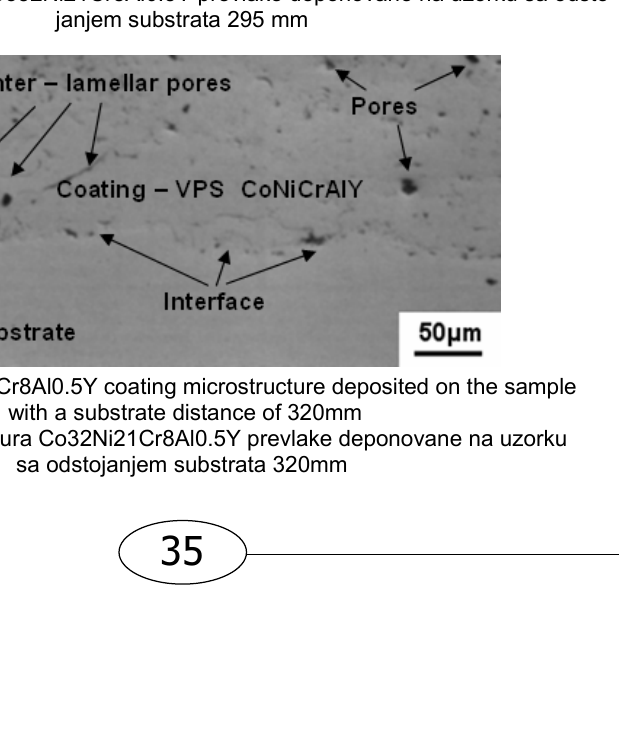
Figure 6 – Co32Ni21Cr8Al0.5Y coating microstructure deposited on the sample with a substrate distance of 295 mm Slika 6 – Mikrostruktura Co32Ni21Cr8Al0.5Y prevlake deponovane na uzorku sa odsto-